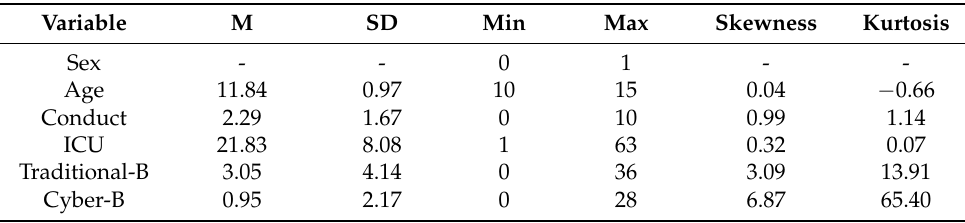
Table 1. Summary of means, standard deviations, minimum, maximum, skewness, and kurtosis of the considered